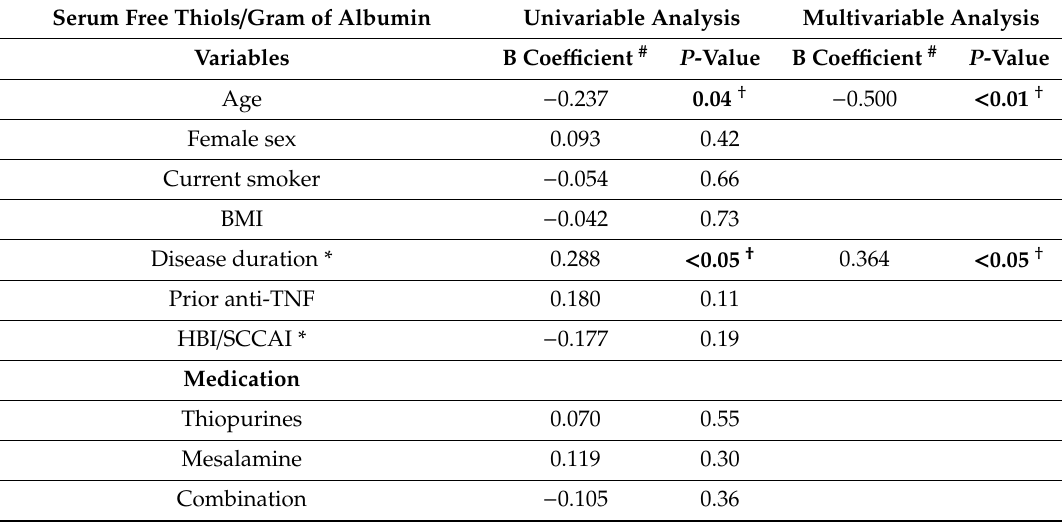
Table 3. Univariable and multivariable linear regression analyses of albumin-adjusted serum free thiols in IBD with clinical and biochemical